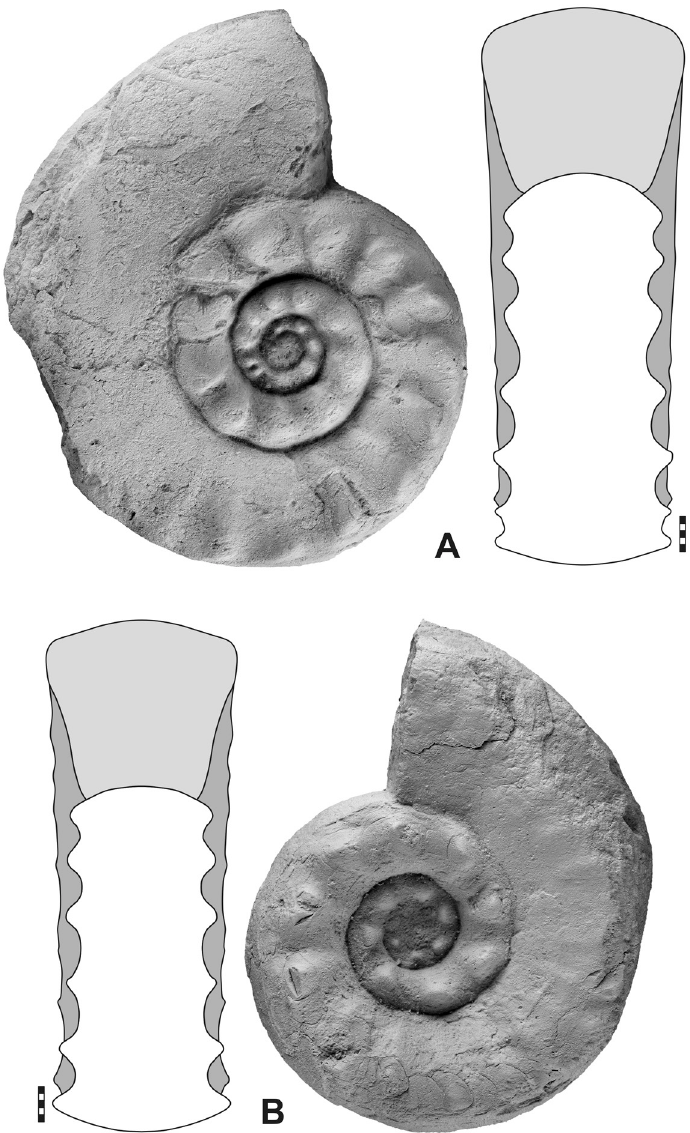
Fig. 26. Paratirolites robustus Korn & Hairapetian sp. nov., lateral and dorsal views. A . Holotype MB.C.29778, section E, -2.95 m. B . Paratype MB.C.29782, float. Scale bar units = 1